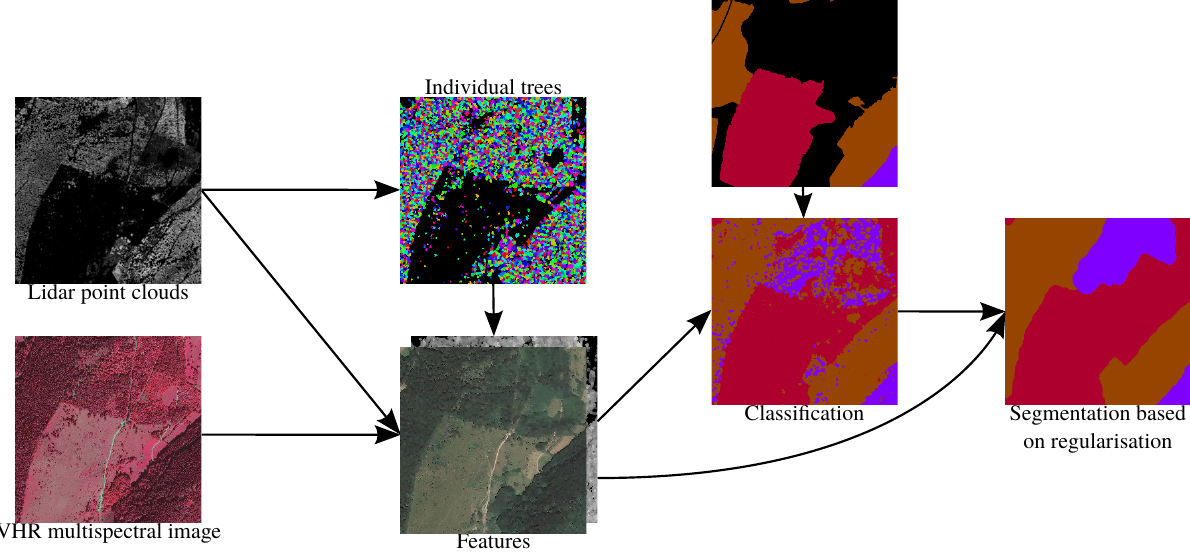
Figure 1. Flowchart of the proposed method. Colour codes : Douglas, spruce, woody